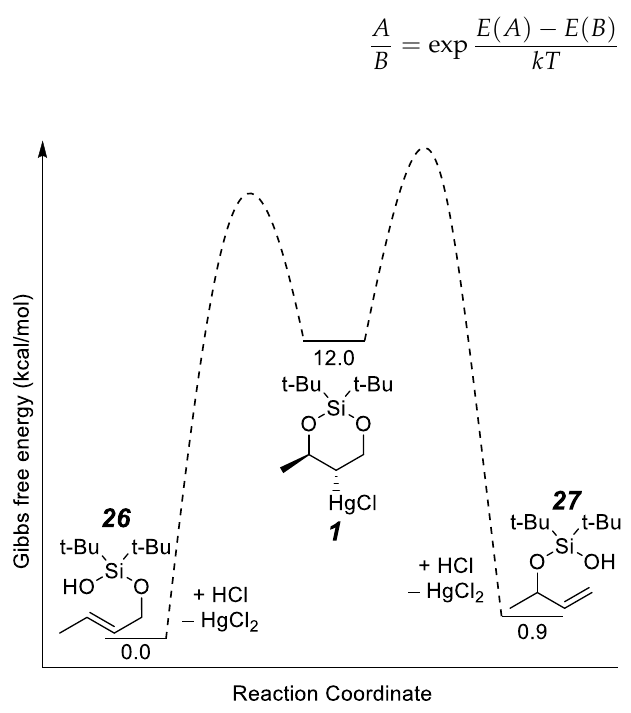
Figure 1. Calculated thermodynamics for methyl substrate 1.